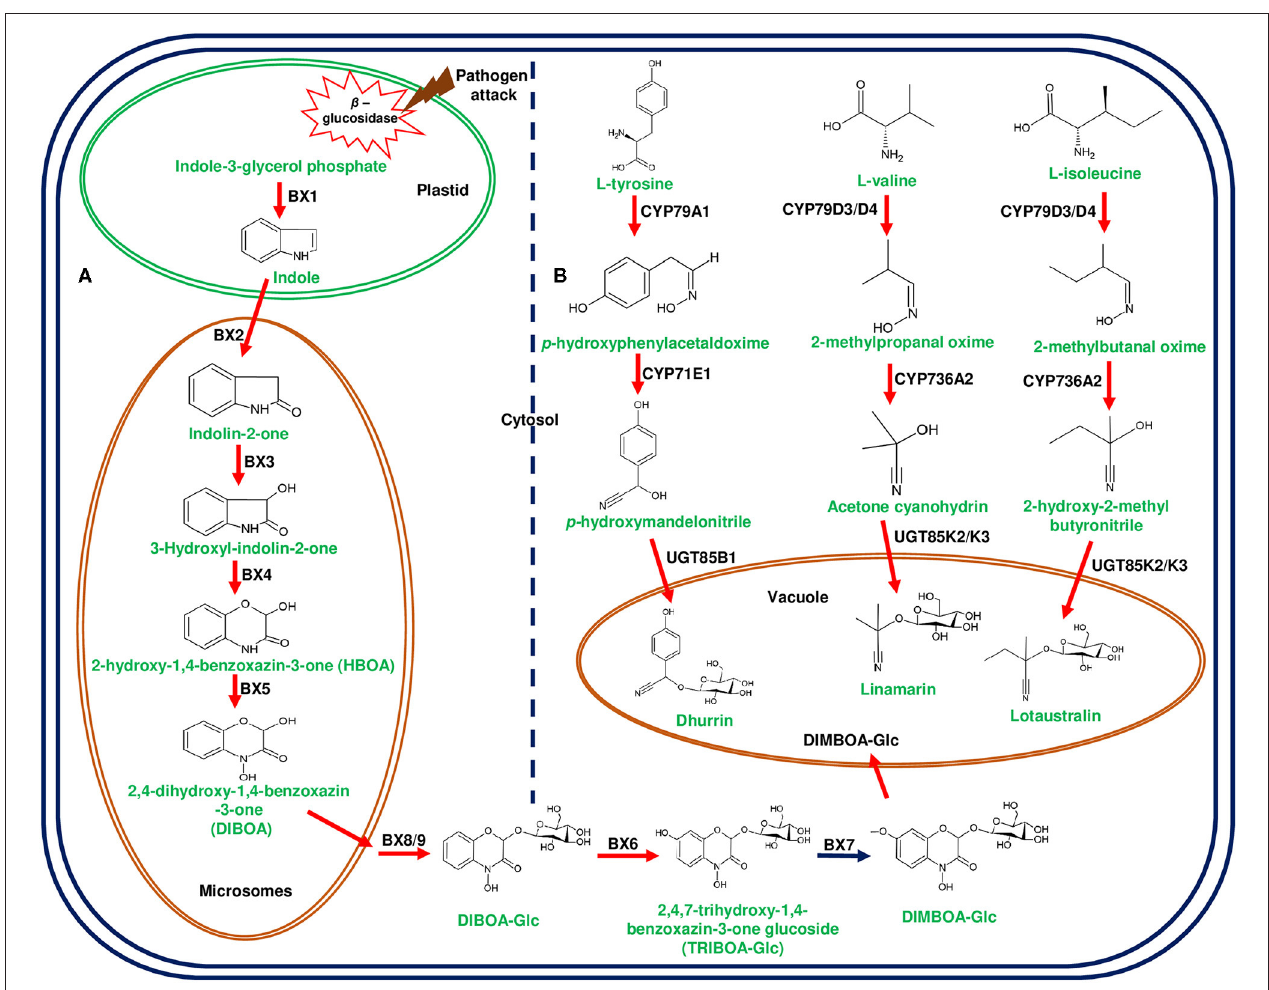
FIGURE 2 | Biosynthetic pathways of 2,4-dihydroxy-7-methoxy-1,4-benzoxazin-3-one (DIMBOA) in Zea mays and cyanogenic glucosides in Lotus japonicus and Sorghum bicolor . (A) represents the biosynthesis of DIMBOA from indole-3-glycerol phosphate mediated by DIMBOA gene cluster in maize. The initial step of indole formation from indole-3-glycerol-phosphate occurs in the plastid catalyzed by benzoxazinless1 (Bx1). The conversion of indole to 2,4-dihydroxy-1, 4-benzoxazin-3-one (DIBOA) occurs in the microsomes through the catalytic reactions of cytochrome P450 enzymes (CYP450s);Bx2-Bx5. DIBOA is transported to cytosol and converted to DIMBOA-glucoside (DIMBOA-Glc) by sequential enzymatic reactions of Bx8/9, Bx6, and Bx7. The glycosylated DIMBOA is transported to the vacuole for sequestration to avoid auto-toxicity. (B) represents cyanogenic glucosides (linamarin, lotaustralin in L. japonicus , and dhurrin in S. bicolor ) produced from different amino acids. L-tyrosine, L-valine, and L-isoleucine are converted into aglycones through the catalytic action of CYP450s belonging to CYP71 family. The final step of glucose addition is catalyzed by UGTs and sequestered in vacuole. Herbivore attack and cell disruption induces the plastidial β -glucosidase activity and releases the glucose moiety from DIMBOA-Glc and cyanogenic glucosides. Genes of the plant metabolic cluster encoding enzymatic reactions are indicated in red